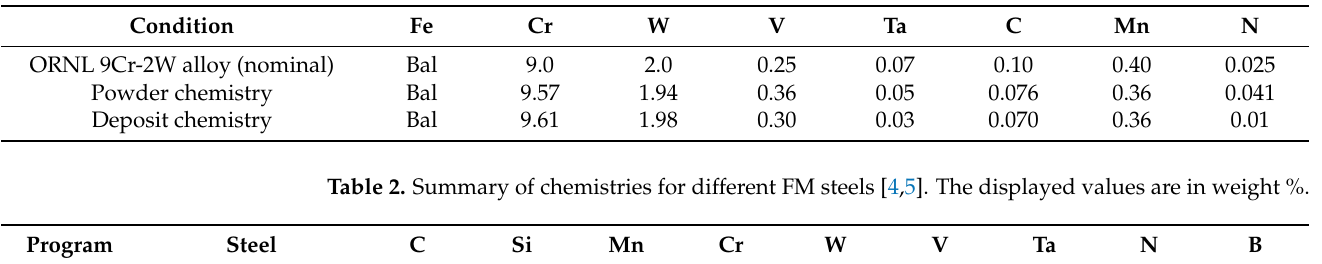
Table 1. Chemistry demonstrating the composition of the alloy used for fabrication determined using are in weight %.